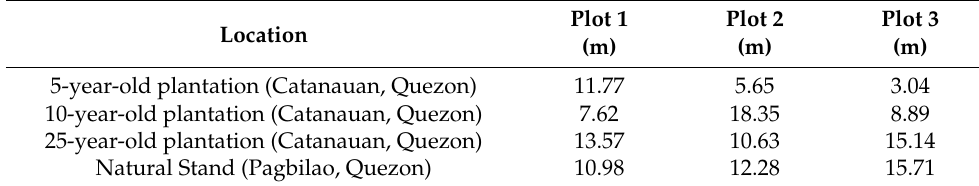
Table 2. Summary of benchmark rod depths